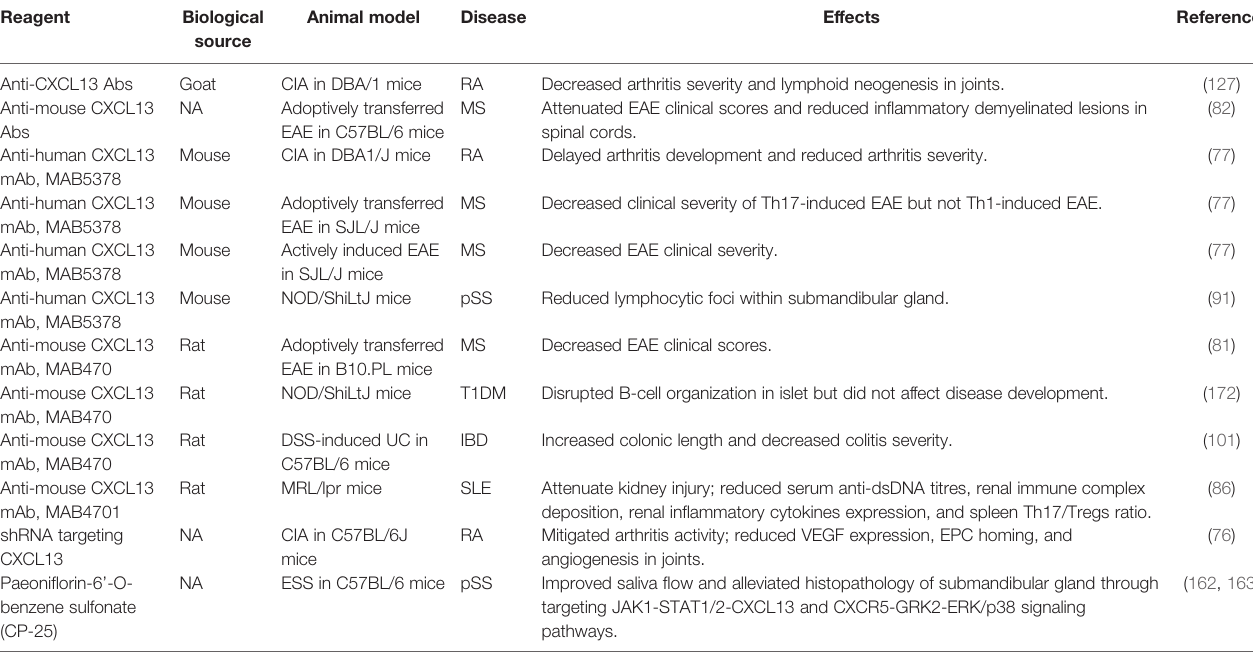
TABLE 2 | Therapeutic effects on targeting CXCL13/CXCR5 axis in autoimmune